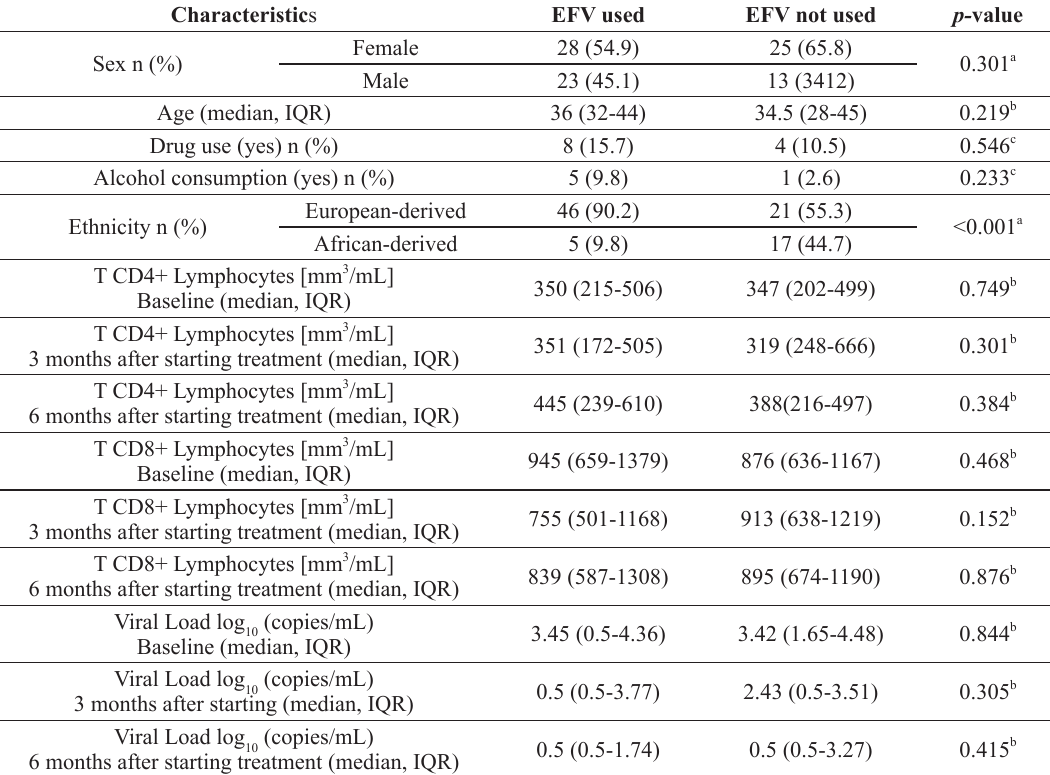
Epidemiological and clinical characteristics of the individuals evaluated in the study. Characteristic